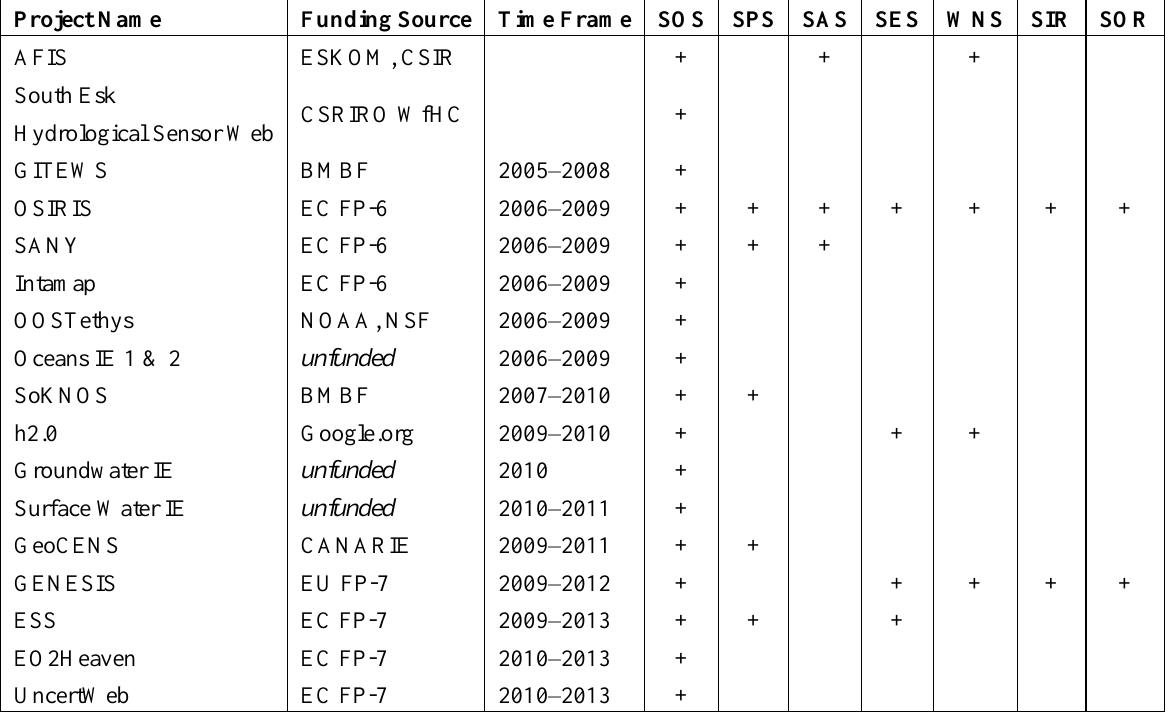
Table 7. Overview of selected projects and their utilization of certain SWE